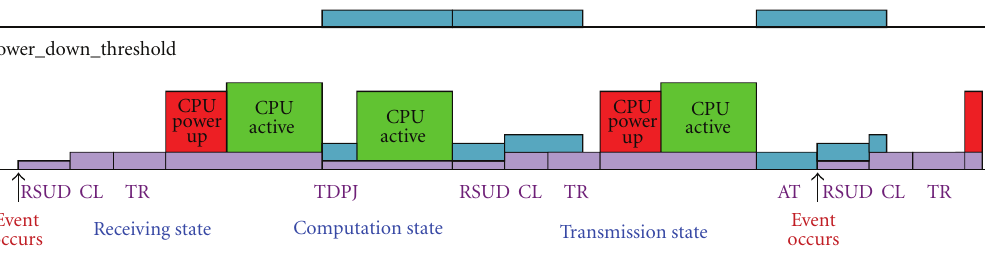
Figure 17: Energy diagram of 2 CPU power ups in one system cycle for closed model (not drawn to scale).